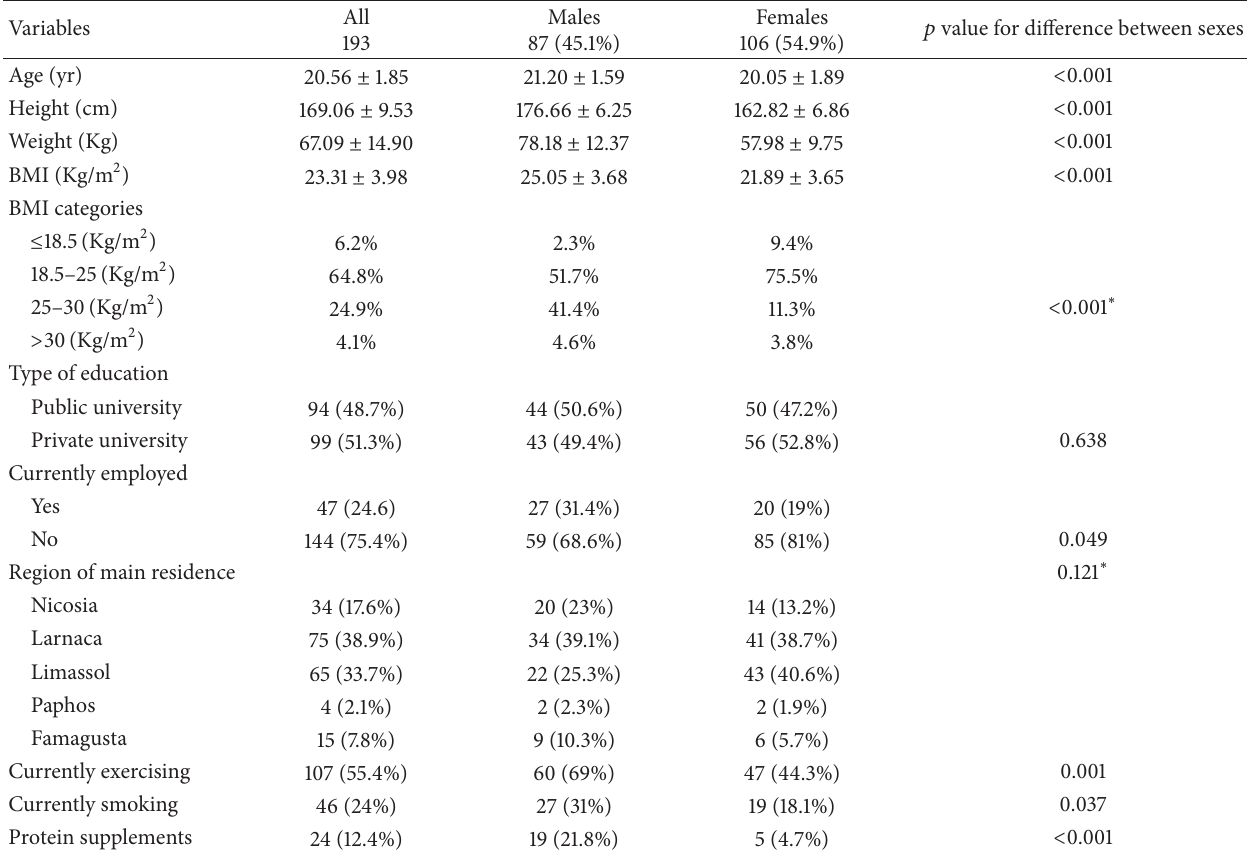
Table 1: Baseline characteristics of study participants.